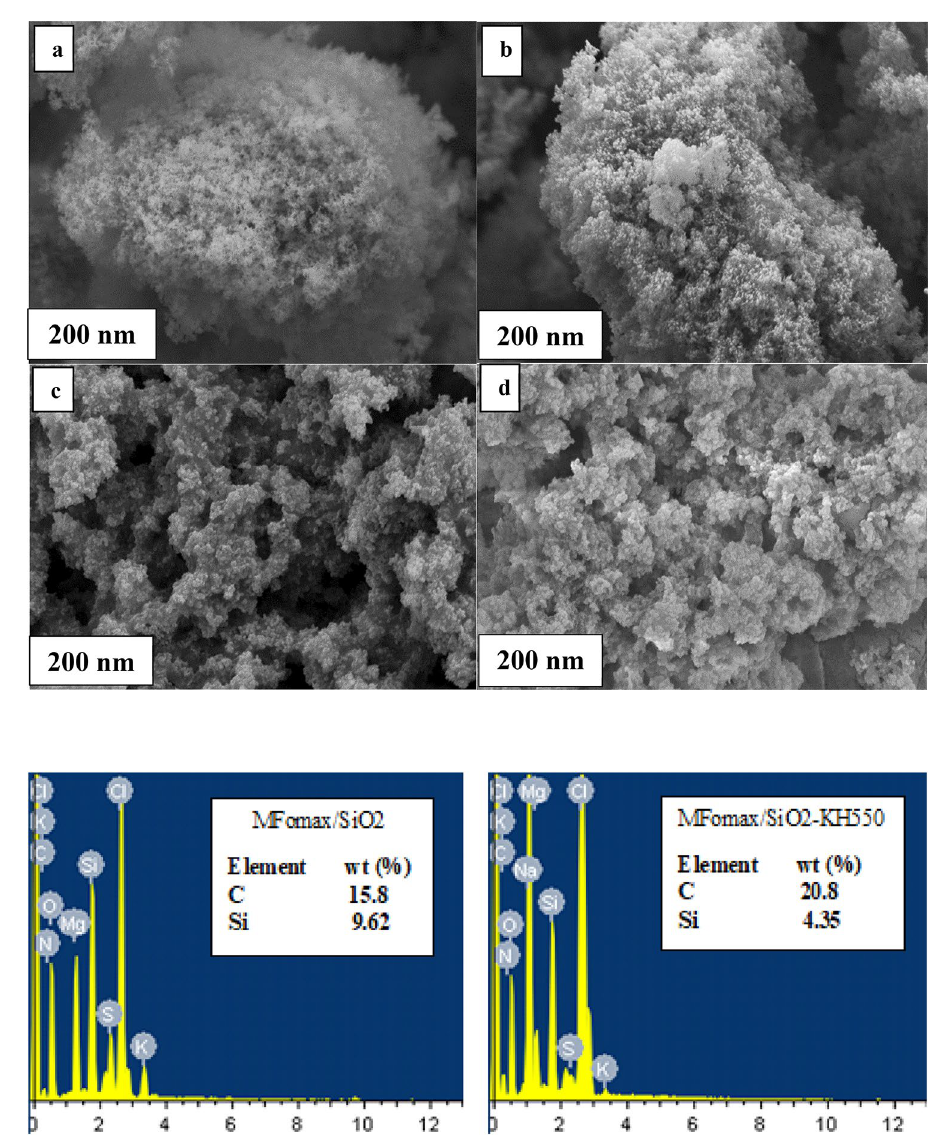
Fig. 9 Comparison of the FESEM micrograph between the pure NPs (a: pure SiO 2 and b: pure SiO 2 -KH550) and the NF (c: MFomax/SiO 2 and d: MFomax/SiO 2 -KH550)